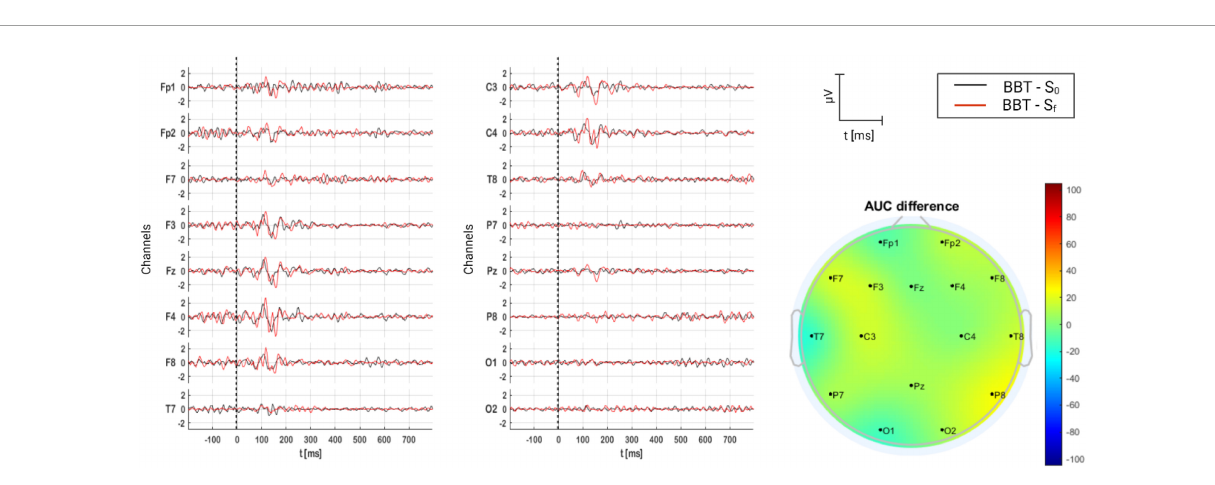
FIGURE12 Grand average of AERPs at S 0 (initial session) and S f (final session) for BBT group. In addition, the AUC difference of these two grand averages (S f – S 0 ) is topographically plotted in µ